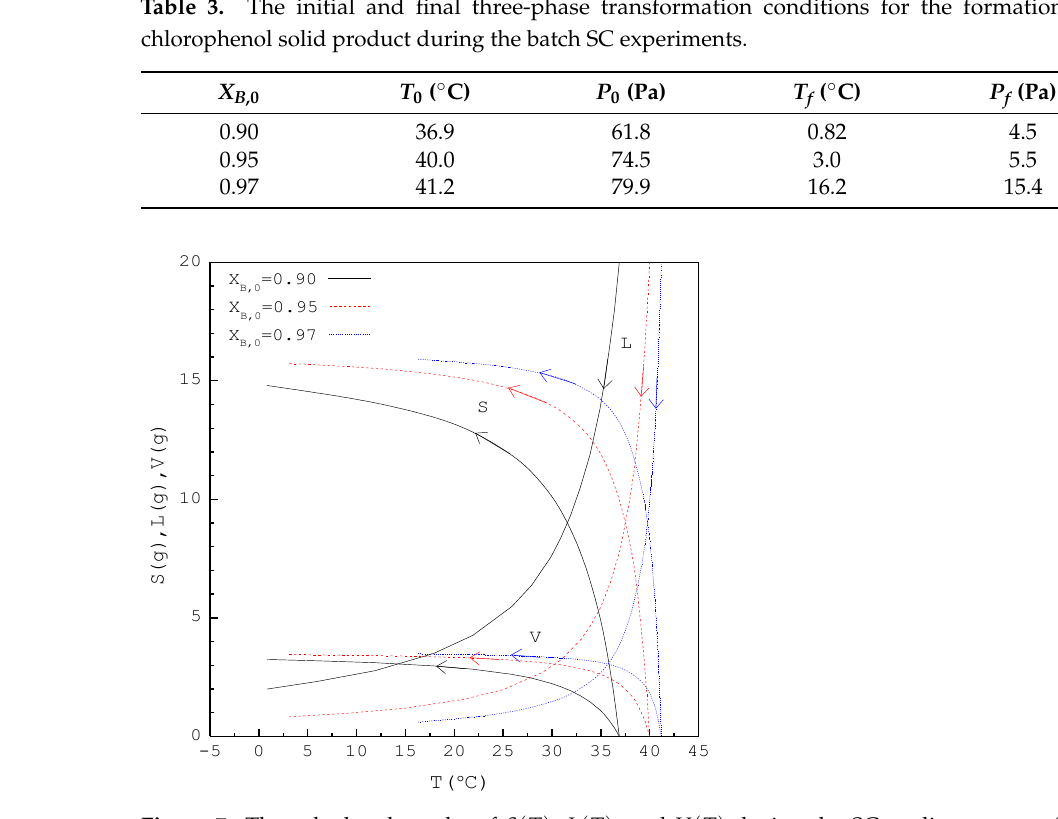
Figure 7. The calculated results of S ( T ) , L ( T ) , and V ( T ) during the SC cooling process for the purification of p -chlorophenol.